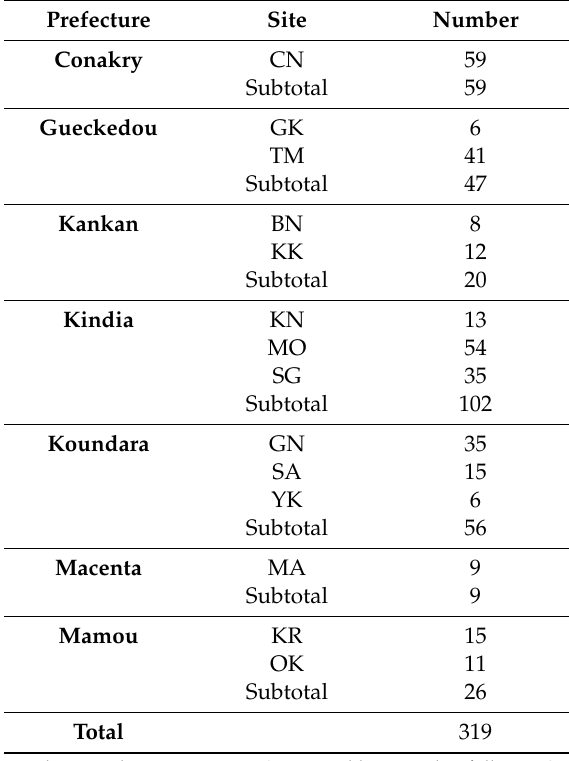
Sites are indicated with a two-letter code as in Figure 1. Sites are abbreviated as follows: CN—Conakry; KN—Kindia; MO—Madina Oula; SG—Sougu é ta; KK—Kankan; BN—Bat é -Nafadji; TM—Termessadou-Dibo; GK—T é